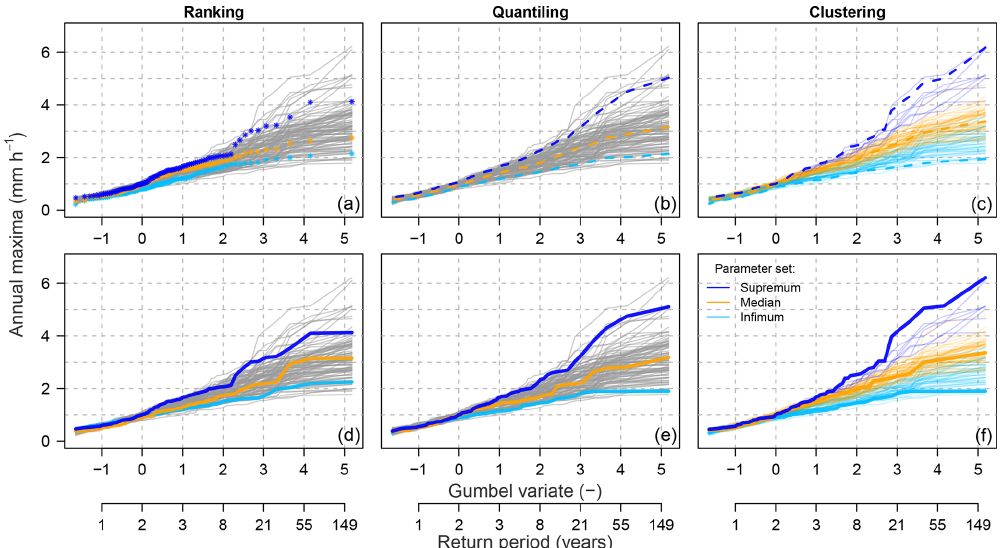
Figure 7. Example of the representative parameter sets’ selection with three methods in the Dünnern at Olten catchment (meteorological scenario m = 93); description as in Fig.